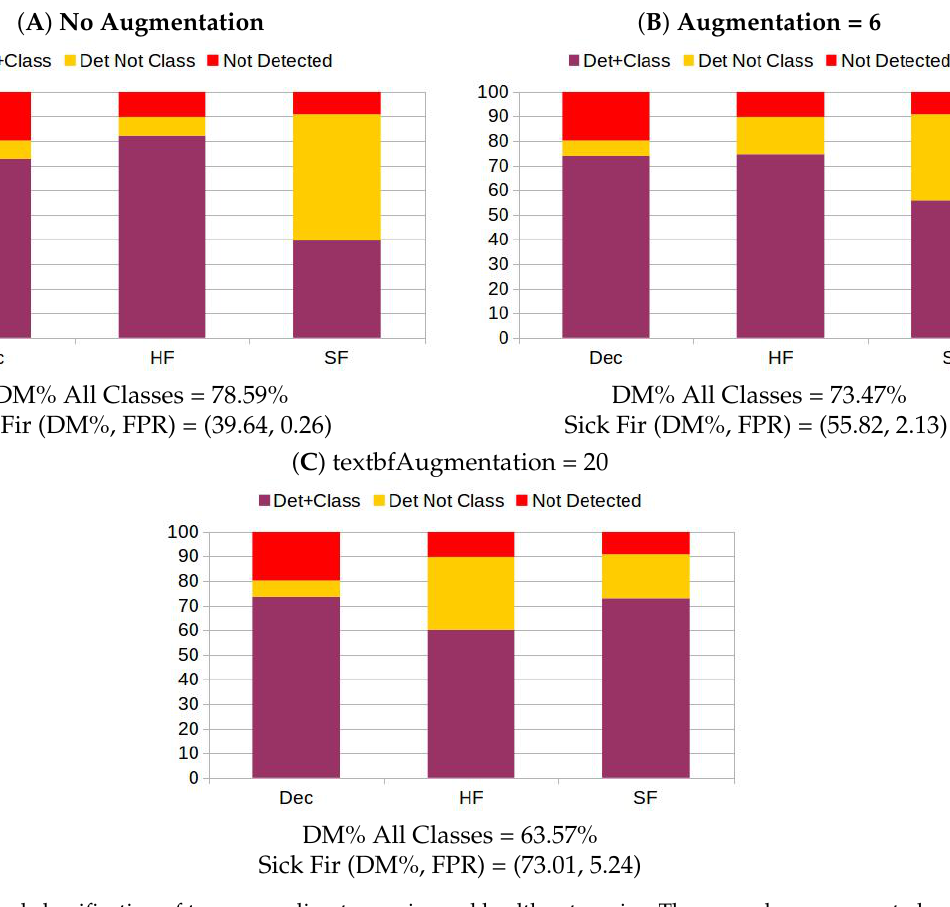
Figure 8. Detection and classification of trees according to species and health categories. Three graphs are presented according to three use cases of our algorithm ( A ) No Data Augmentation. Focus on species separation, ( B ) Data Augmentation = 6. Balanced Use case. ( C ) Data Augmentation = 20. Focus on Sick Fir detection. The graphs include: Percentage of treetops missed in the detection step (top), Percentage of treetops detected but not classified correctly (middle) and Percentage of treetops detected and classified correctly (down). Each graph contains information on the three classes studied: Healthy Fir (HF), Sick Fir (SF) and Deciduous (BL). Finally, the percentage of trees correctly detected and classified over the three classes is provided as “DM% All Classes”. The percentage of correctly detected and classified Sick Fir trees as well as the ratio of False Positive predictions (FPR) for the same category are also provided. All the percentages reported correspond to the total number of trees present as expressed by the ground